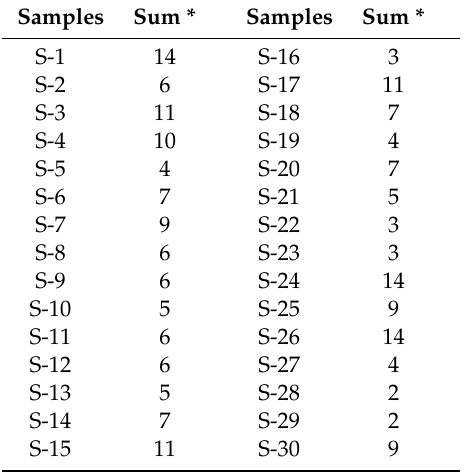
Table 6. Total Htyr and Tyr (free and bound forms) content (mg / 20 g oil) of VOO samples according to protocol